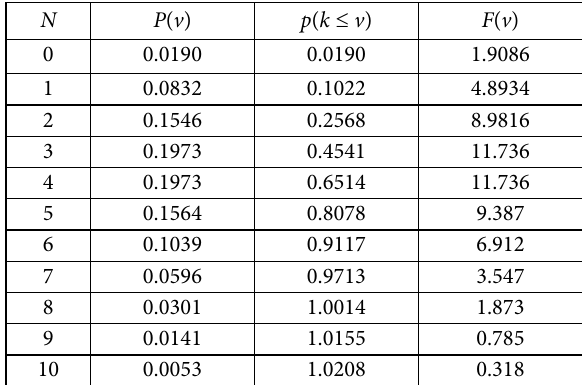
Table 1. Probability of vehicles arrival